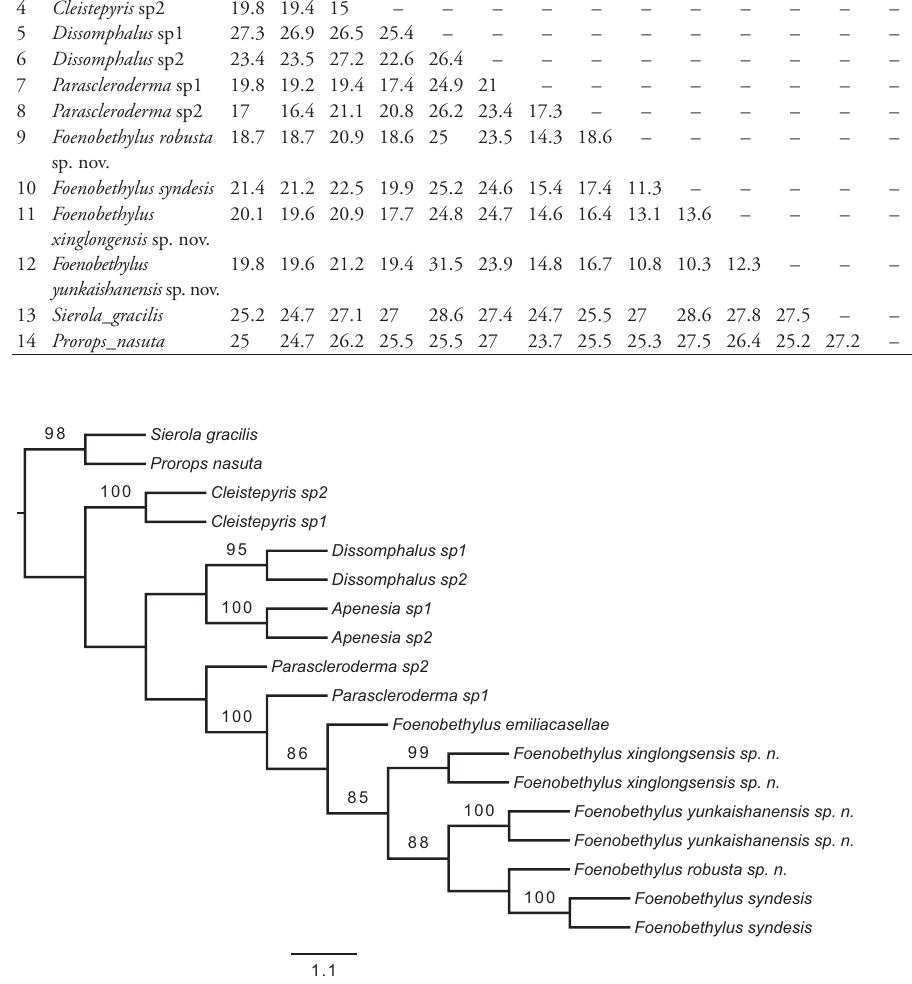
Figure 1. Maximum likelihood tree demonstrating the clustering of Foenobethylus and related genera based on concatenated sequences ( COI and 28S